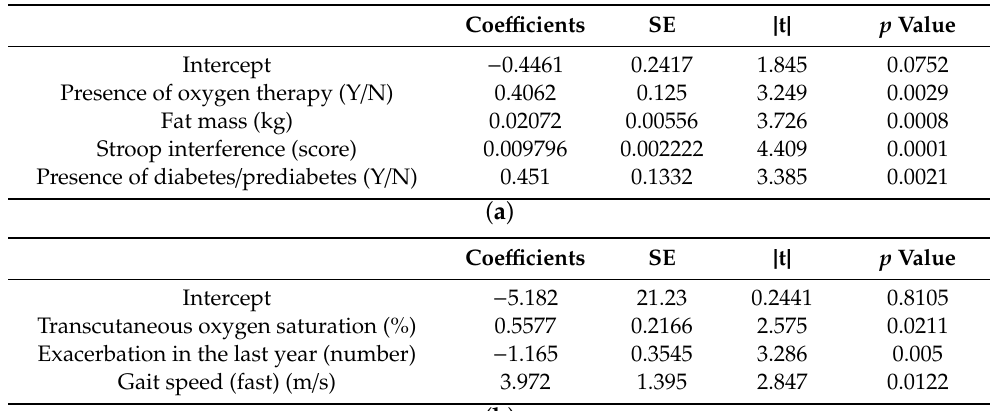
Table 3. Multiple linear regression model with postural balance by CoP ( a ) and BBS ( b ) in the COPD group. Coe ffi cients